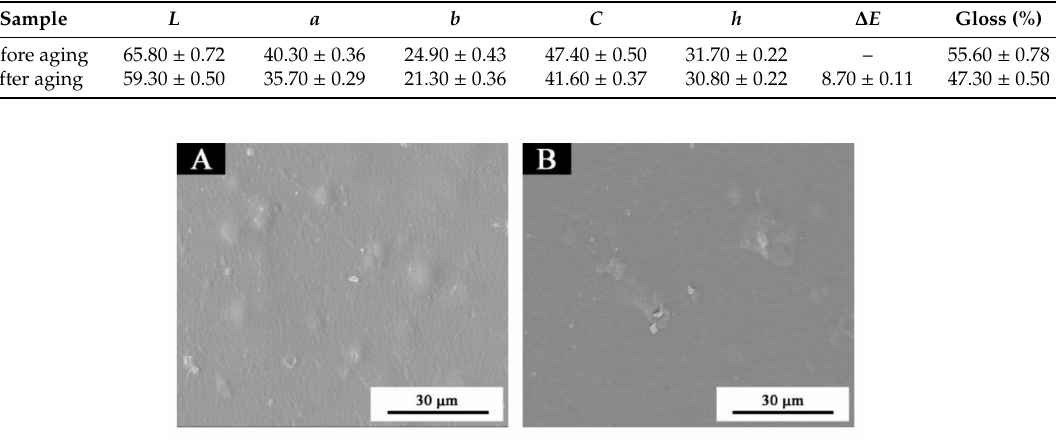
Table 13. Color value and gloss of waterborne wood coating before and after aging.